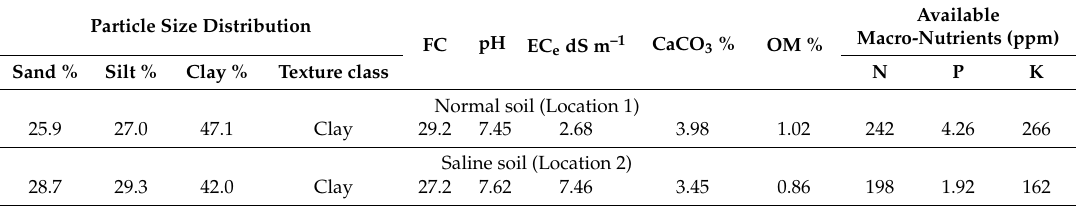
Table 1. Physico-chemical properties of the experimental